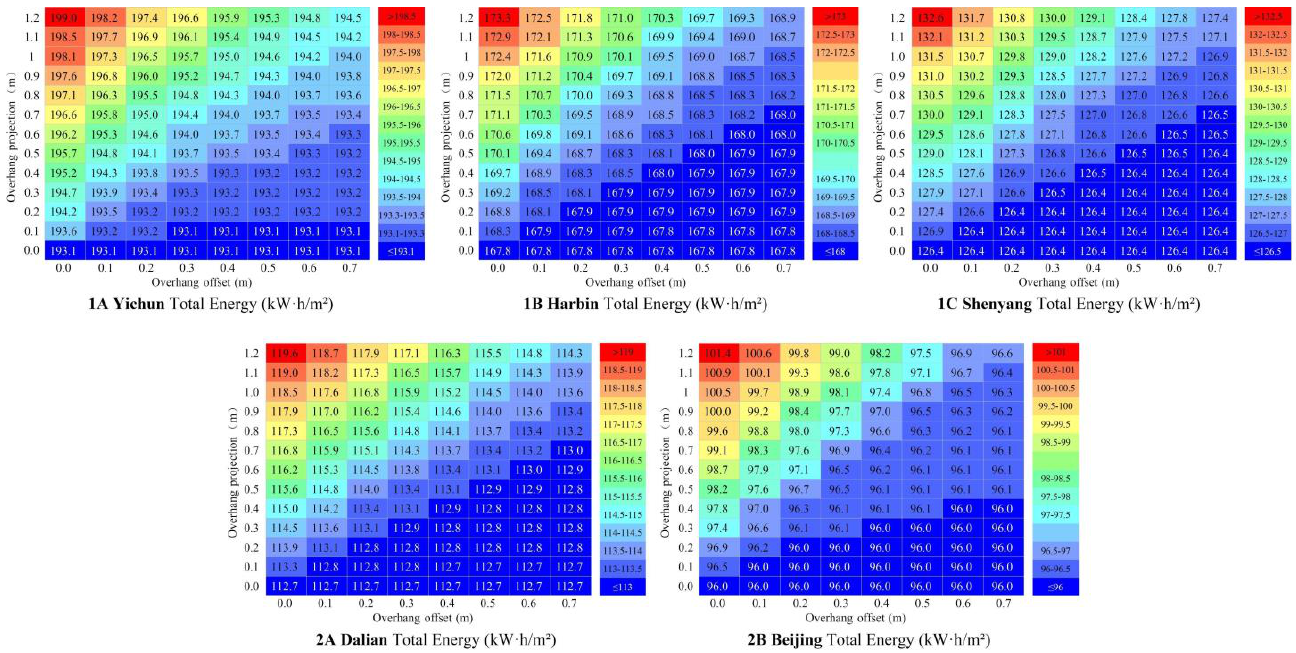
Figure 13. Total annual energy consumption of the case building.